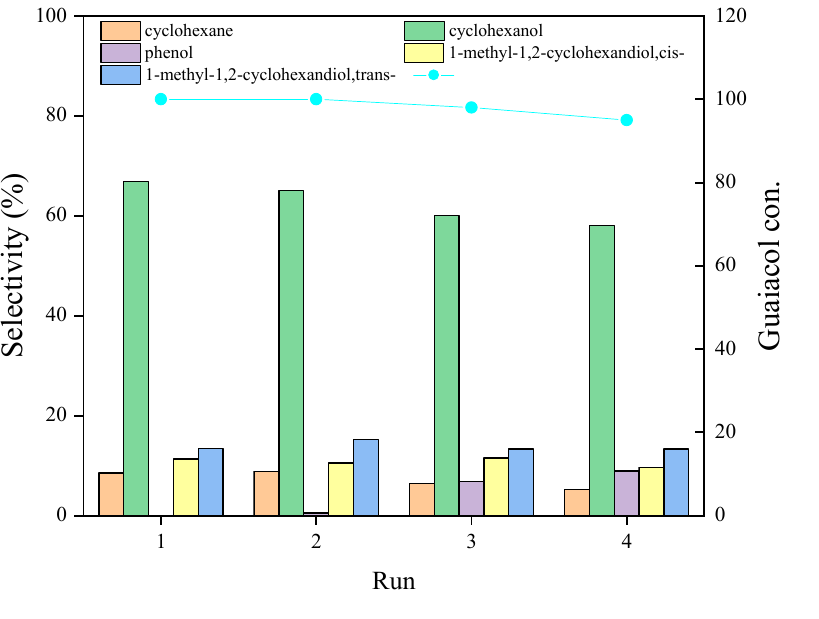
Figure 8. Reusability of the Ni3Mo1@C catalyst.